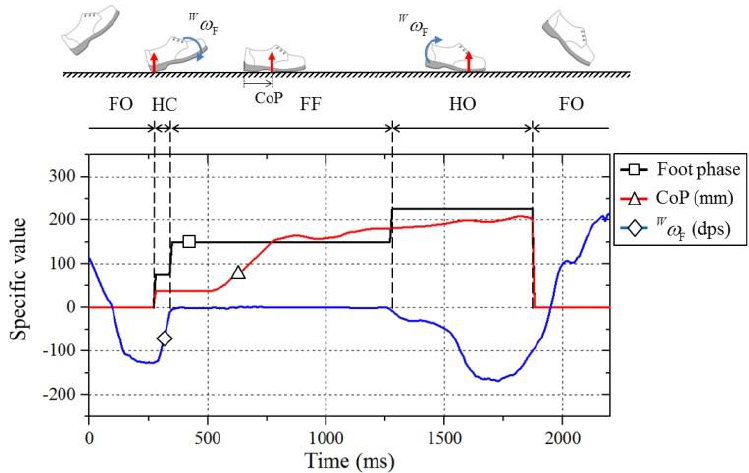
Figure 15. Foot contact phase determination result using the CoP and the angular velocity of the foot ( ω F ) with respect to frame {W}.